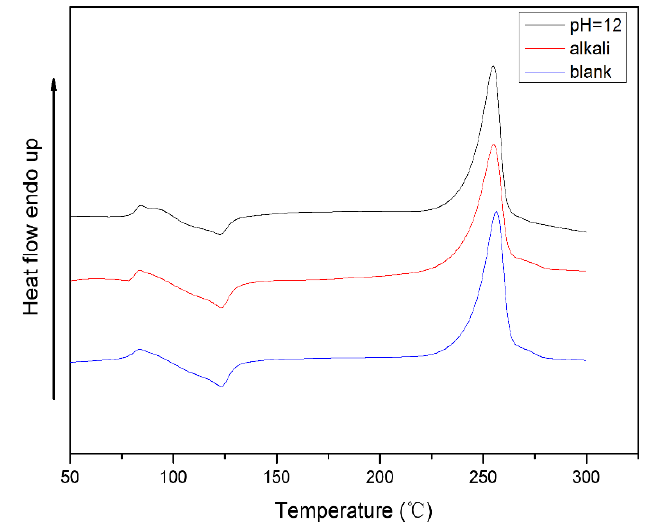
Figure 8. Differential scanning calorimetry thermogram analysis of PET treated by alkali-resistant strains and PET treated by alkalis.